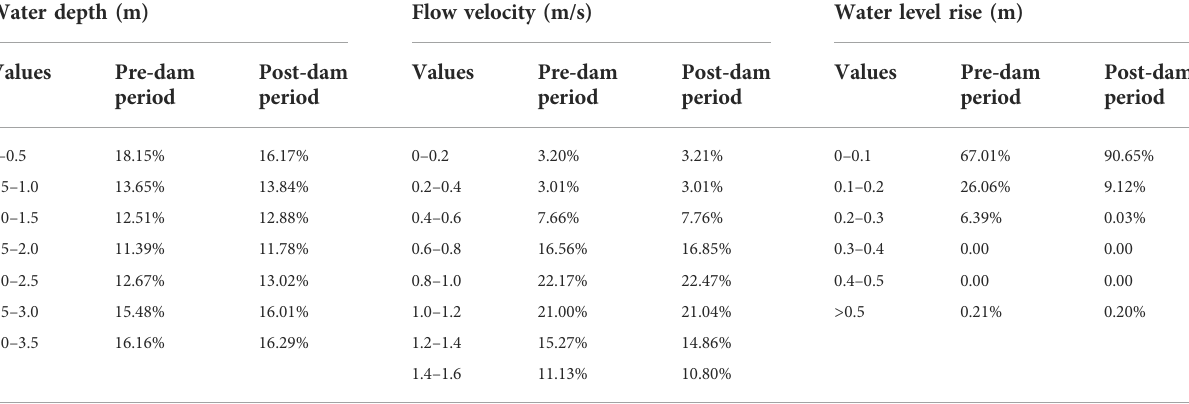
TABLE3Comparisonoftheproportionsofnumericalgridsofhabitatfactorsduringthepre-andpost-damperiodsattheXiaolangdiReservoironthe Yellow River, China.